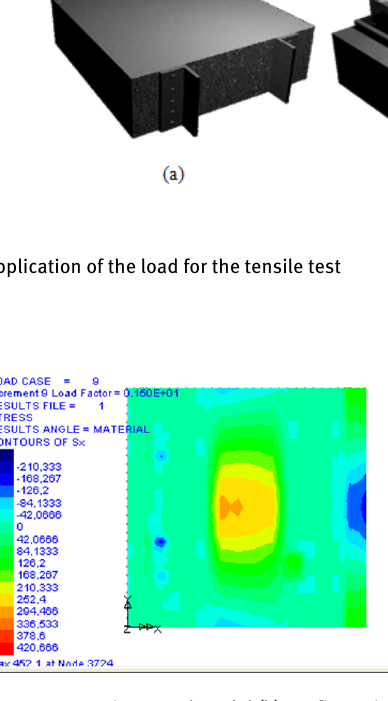
Figure 25: Stress contour in control model (b) configuration l Figure 26: Stress contour in strengthened model (b) configuration